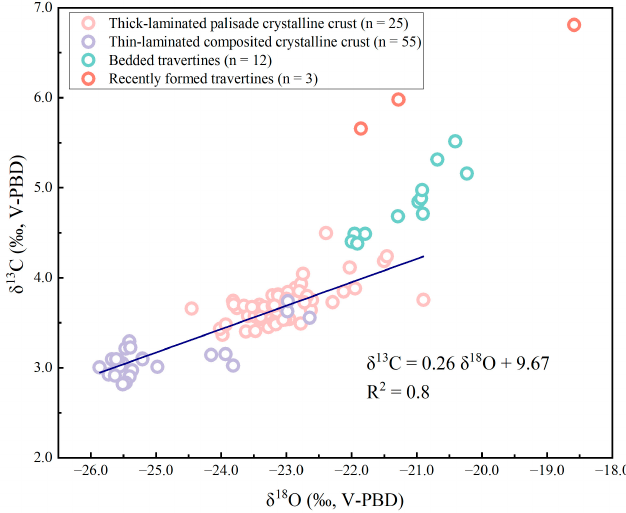
Figure 5. Diamond box plots showing the relationships between lithotypes and δ 13 C ( A ), between lithotypes and δ 18 O ( B ), between lithotypes and T cal ( C ), and between lithotypes and δ 13 C parent CO2 ( D ) . thick-laminated crystalline crust (TP), thin-laminated composite crystalline crust (TC), bedded